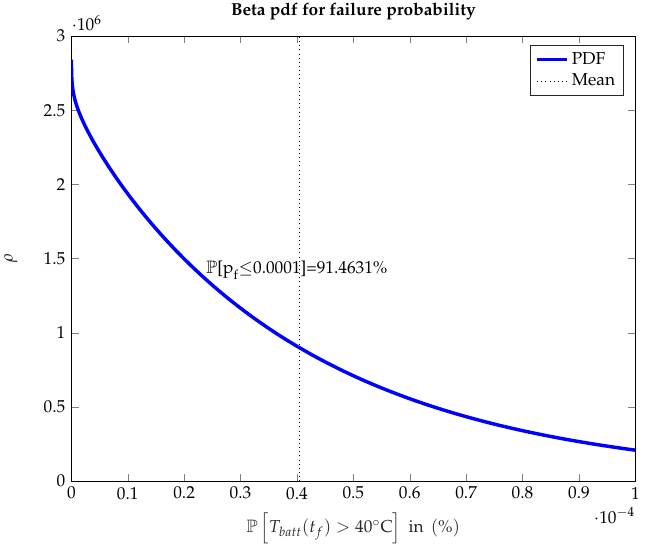
Figure 9. Estimation of failure probability density function for charge–discharge cycle from subset simulation for the final point on an optimization time horizon using a Beta distribution with mean value and probability density function area estimation until the allowed failure